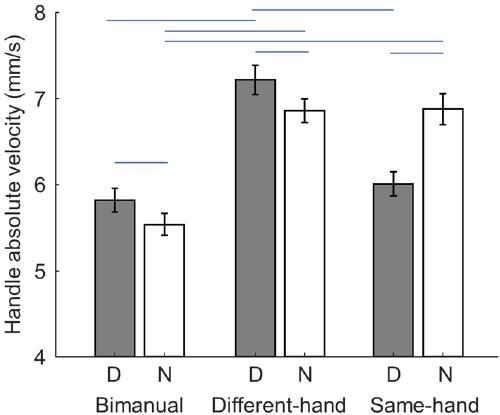
Figure 3. Handle movement velocity. The mean absolute value of handle vertical velocity are shown for each hand (mean ± S.E.; Dominant: D, Non-dominant: N). Conditions joined by the two ends of the blue horizontal lines are statistically